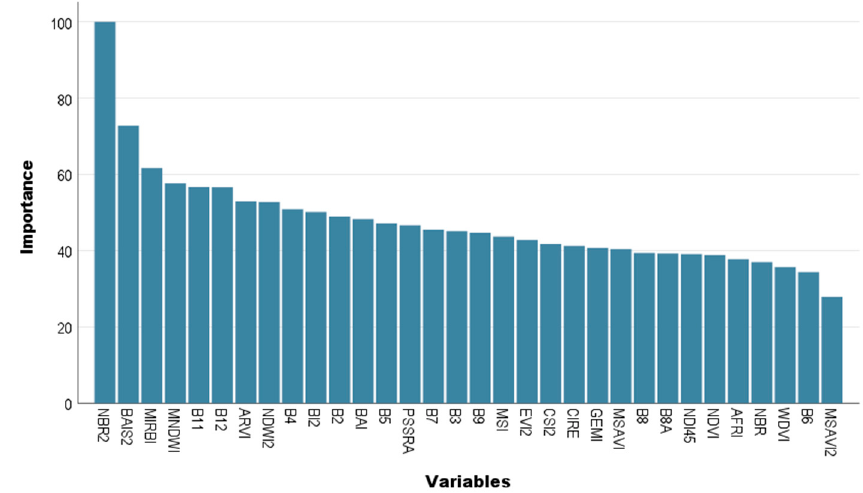
Figure 5. Importance values of the variables derived from Sentinel-2 determining the detection of fires. The most influential variable is the Normalized Burn Ratio2 (NBR2). Other variables are ranked based on their importance relative to NBR2.